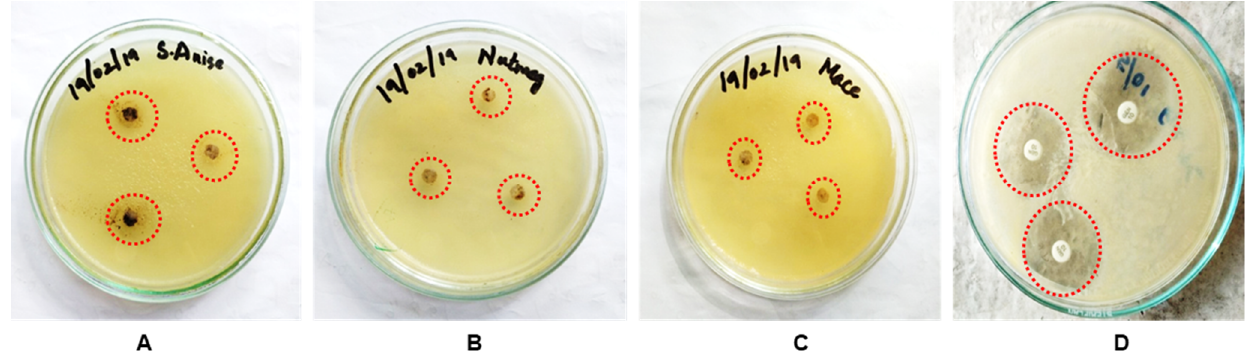
Figure 8. Growth of S. aureus showing the zone of inhibition (circled in red) in the presence of CuNPs formulated with spice extract: ( A ) star anise, ( B ) nutmeg, ( C ) mace, and ( D ) gentamycin, a positive control, by disc diffusion method. Table 4. ZOI values of CuNPs synthesized with spices by disc diffusion method. Scheme 1.